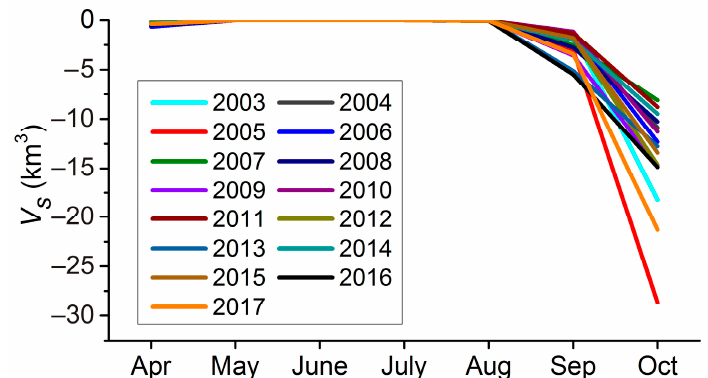
Figure 5. Seasonal variation of V s . The largest negative value occurred in October 2005.